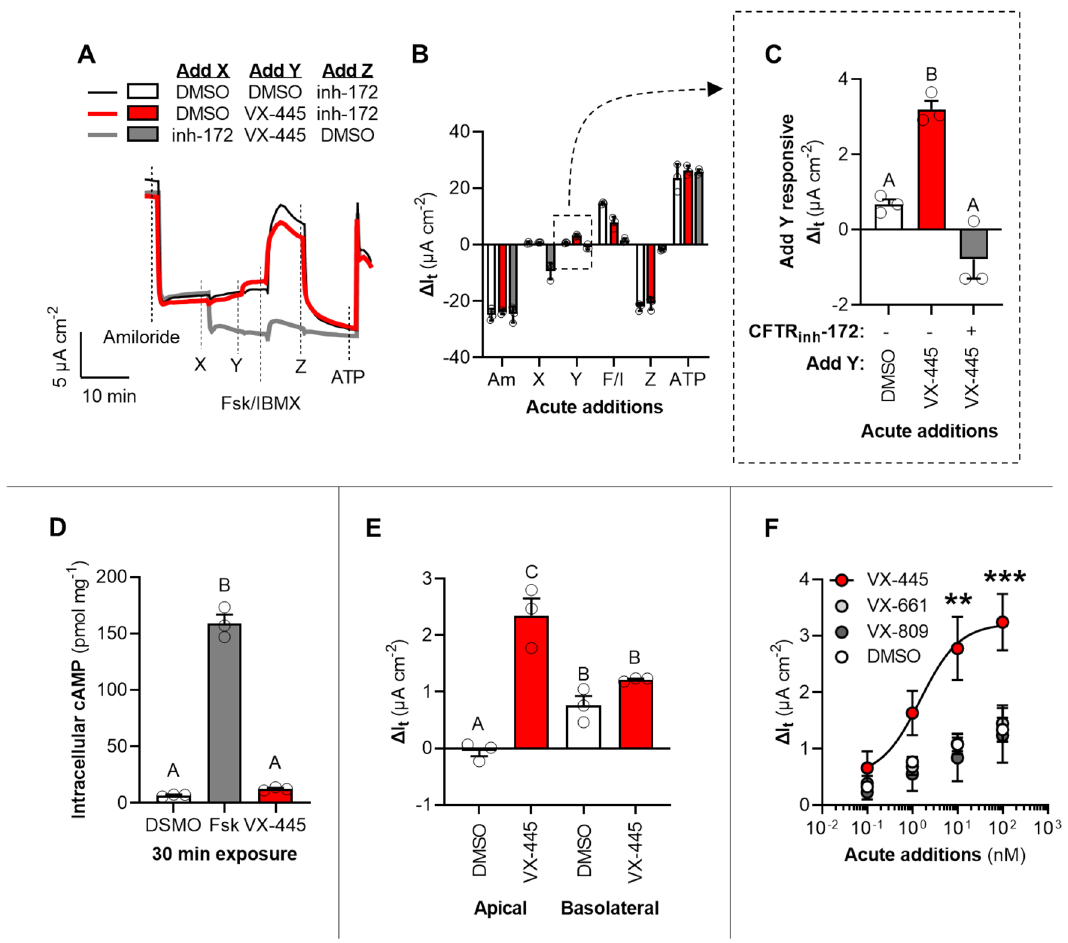
Figure 1. Acute potentiation of CFTR by elexacaftor (VX-445) in primary-derived non-CF human nasal epithelia. ( A ) Representative I t recordings showing response to acute additions of amiloride (100 µM), DMSO, VX-445 (100 nM), Fsk (20 µM)/IBMX (100 µM), and/or CFTR inh -172 (100 µM). Acute additions indicated by a letter (X, Y, Z…) correspond to interventions listed in the key in Panel A. ( B ) Changes in I t after the additions of test compounds for the experiment presented in Panel A . ( C ) Change in I t after acute addition Y, demonstrating the CFTR-specific potentiation of VX-445. ( D ) Intracellular cAMP after 30 min exposure to DMSO, Fsk, or VX-445. ( E ) Sidedness of immediate (within 5 min) action of VX-445 compared to DMSO controls. ( F ) Concentration–response curve for VX-445 and other CFTR correctors, tezacaftor (VX-661) or lumacaftor (VX-809). Only VX-445 significantly increased I t compared to a DMSO control (denoted by asterisks; EC 50 : 1.50 ± 1.40 nM). See Supplementary Materials for additional experimental details and for supporting data. All data are presented as mean ± standard error. Bars with different letters (A, B, C…) are significantly different from each other (ANOVA; P < 0.05). Asterisks indicate specific P values: ** P < 0.01; *** P <